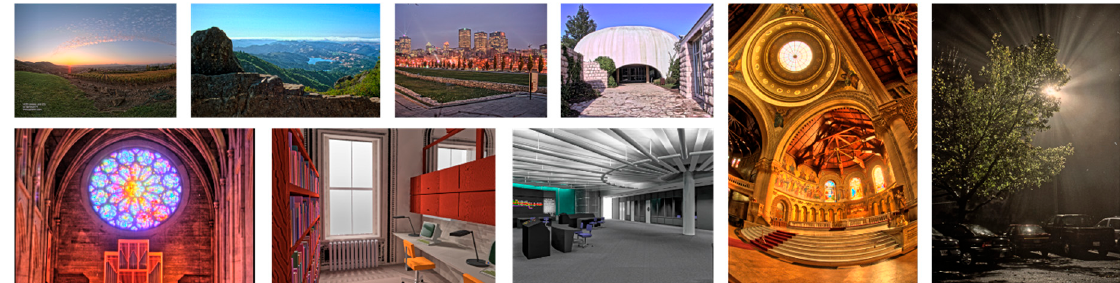
Figure 12. Part of test images from dataset [29]. Images 1 to 4—First row from left to right: SpheronNapaValley_oC5D, MtTamWest_o281, Montreal_float_o935, and dani_synagogue_o367. Images 5 to 7—Second row from left to right: rosette_oC92, rend11_o972, and rend08_o0AF. (Image 8) First from the right: memorial_o876. Image 9: Second from the right: bigFogMap_oDAA. All the images were processed using the proposed method. Table 1. List of 33 test images from the dataset from [29] and their dynamic ranges (D). No.